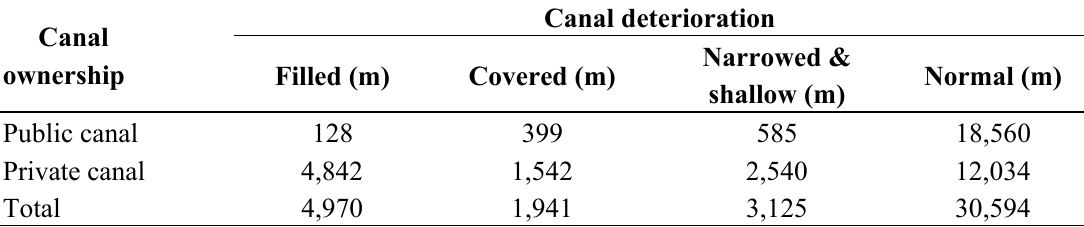
Table 3. Length of canal deterioration in relationship to public-private ownership of